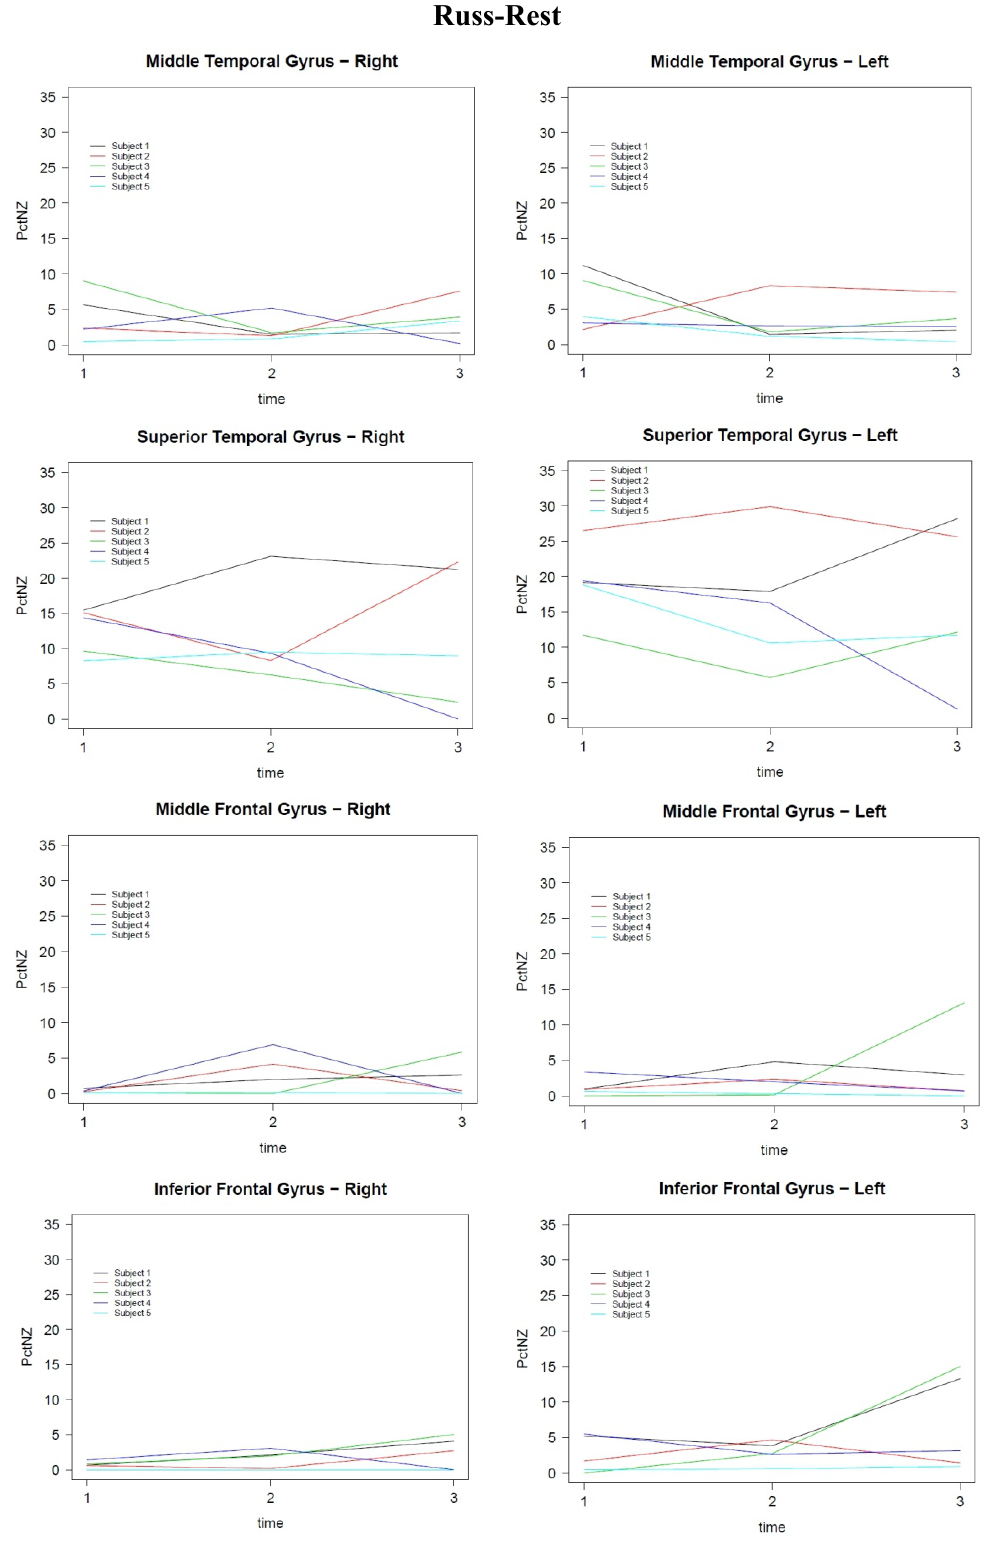
Figure 2. Percentage of nonzero voxels (PctNZ) for five subjects by ROI and hemisphere over three scans (time), for conditions (Russ-Rest, Eng-Rest).